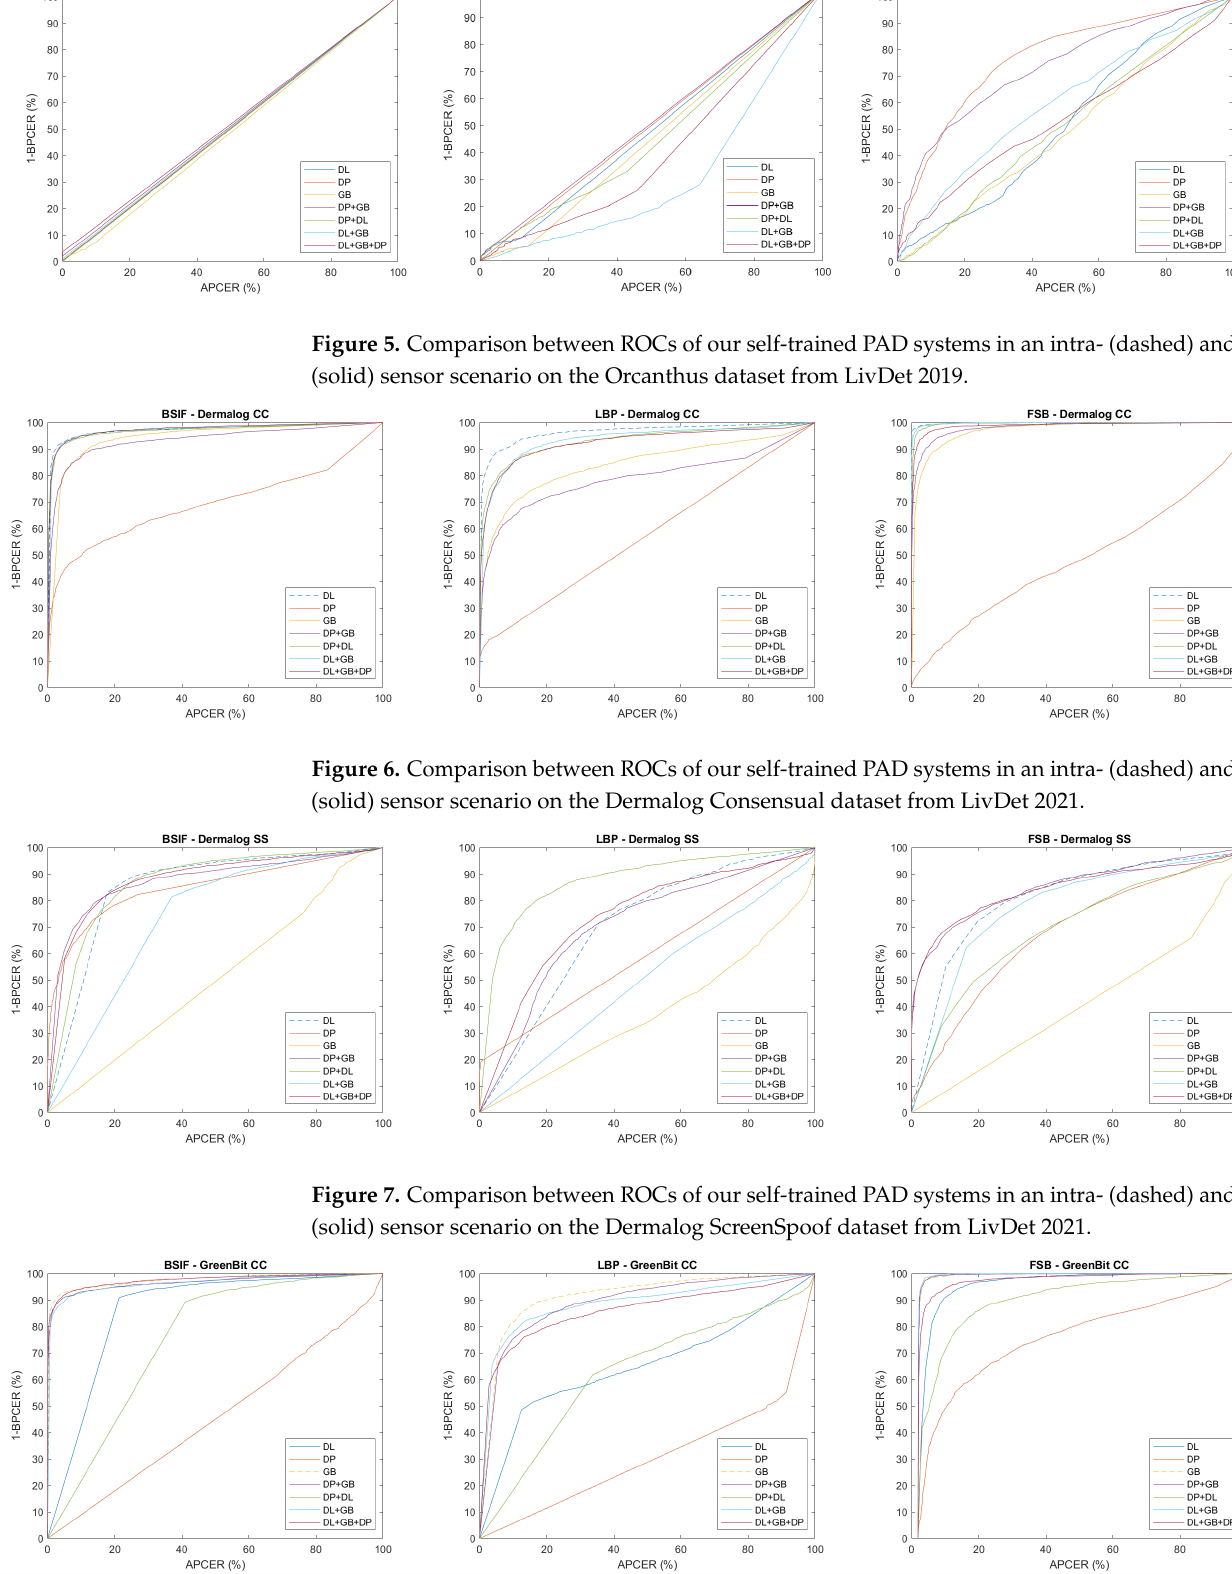
Figure 8. Comparison between ROCs of our self-trained PAD systems in an intra- (dashed) and cross- (solid) sensor scenario on the GreenBit consensual dataset from LivDet